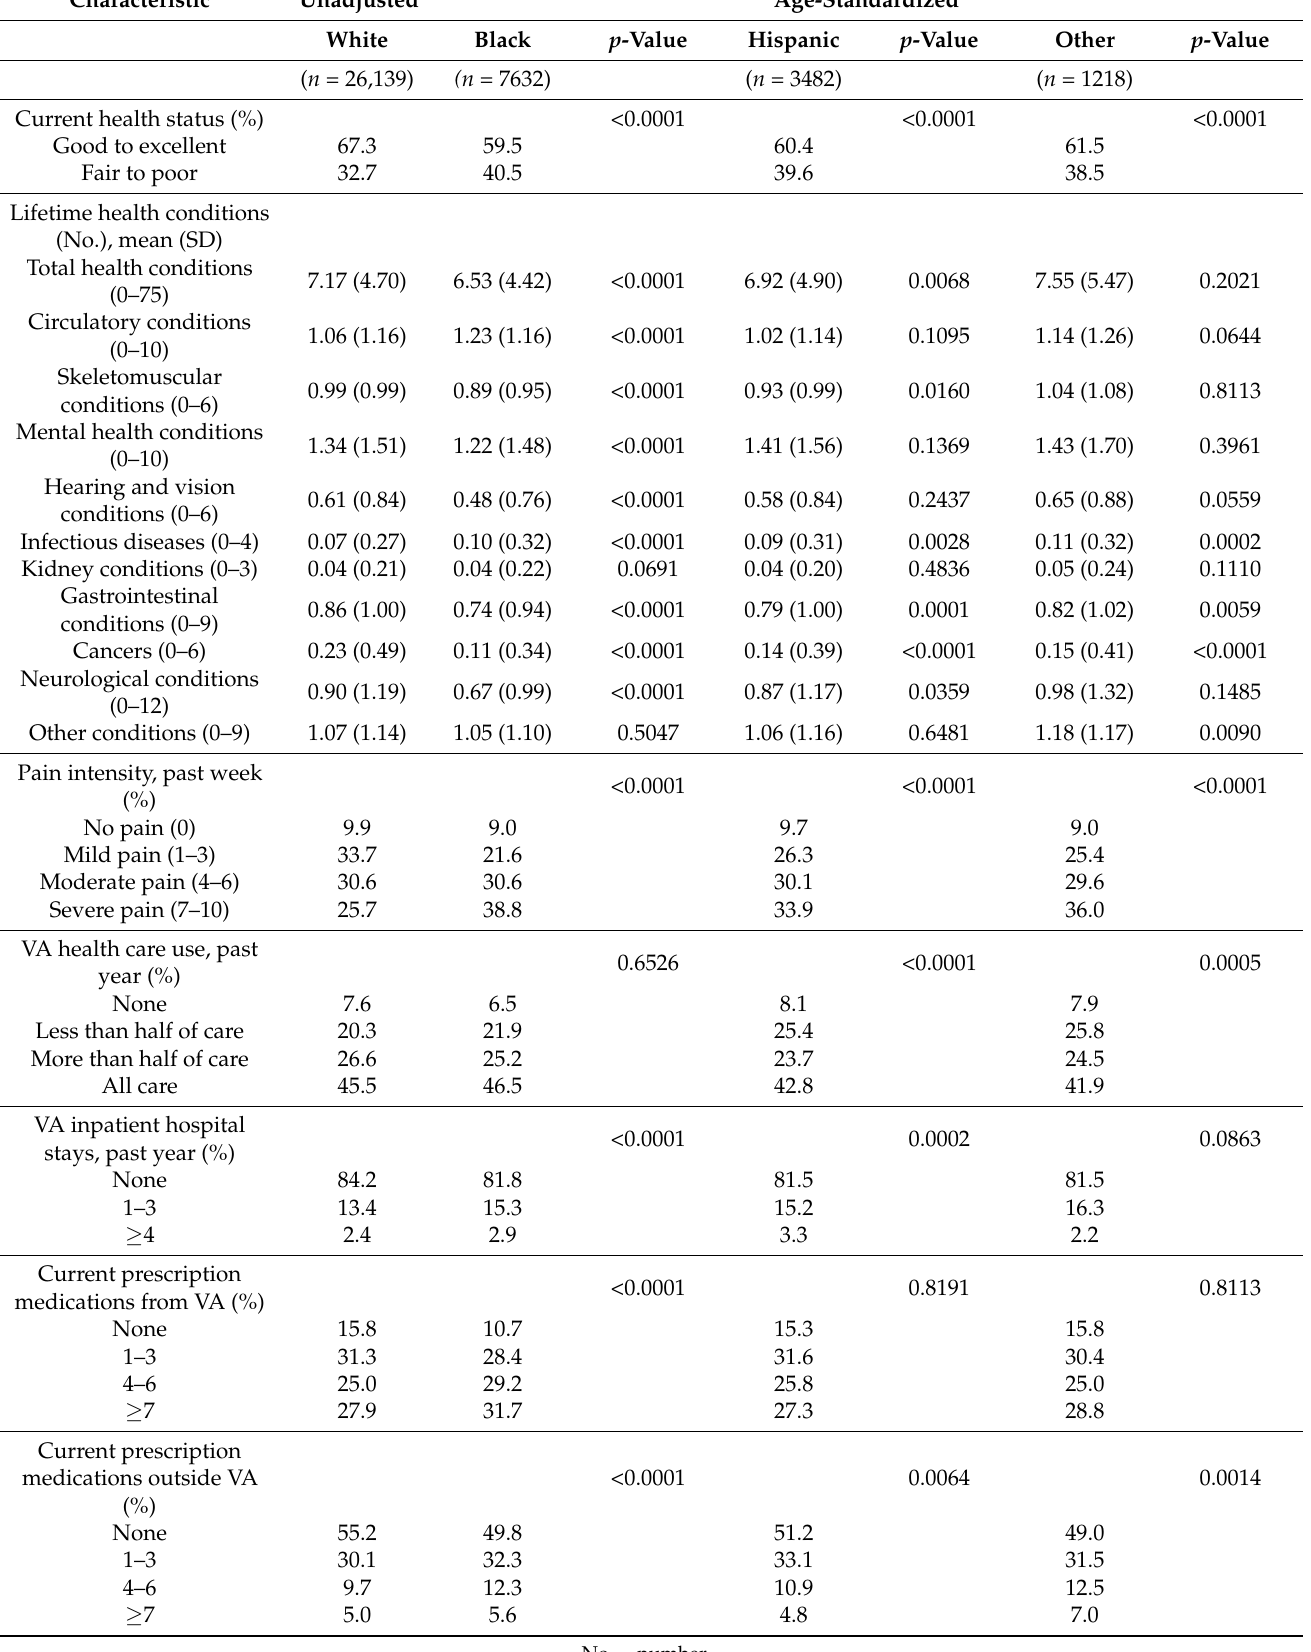
Table 4. Health-related Characteristics of Women from the Million Veteran Program by Race and Ethnicity. Characteristic Unadjusted Age-Standardized White